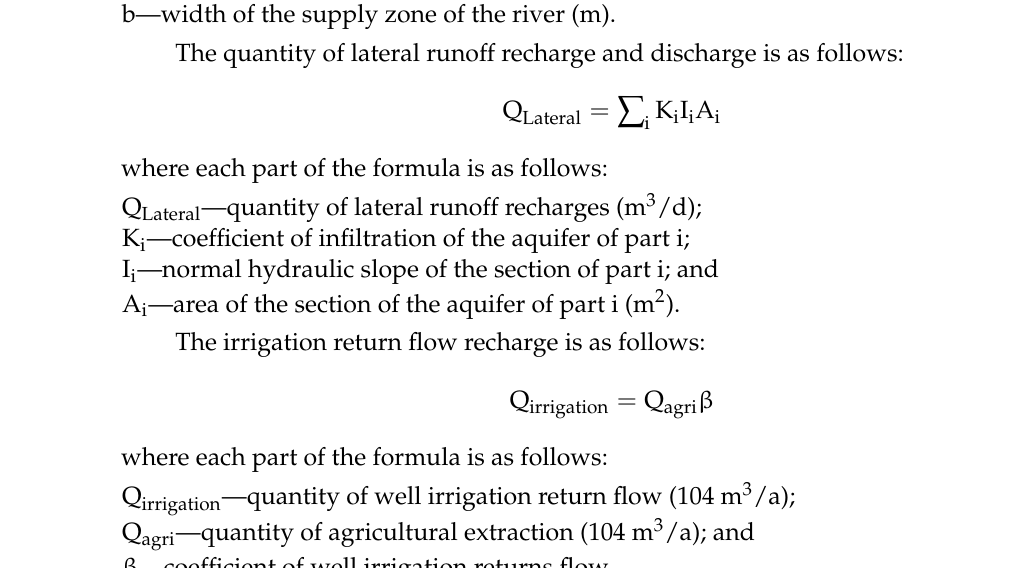
Figure 7. Parameter partitions. Table 2. Initial parameter values of the model. Number